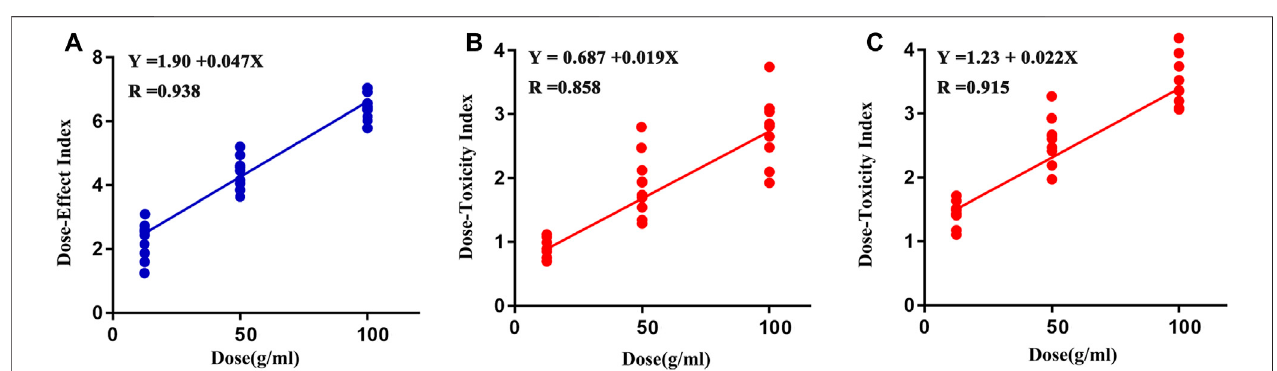
FIGURE 11 | Regression curve of dose-effect/toxicity relationship in CUMS (A, B) and normal rats (C) .